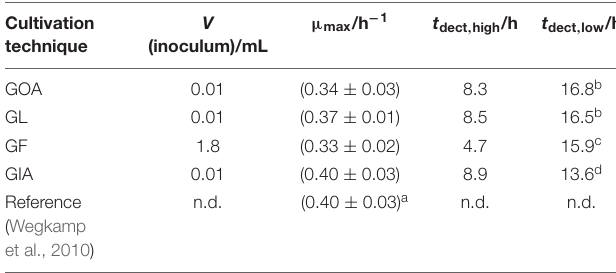
TABLE 1 | Summary of the results with different cultivation techniques combined with IMC experiments. Cultivation